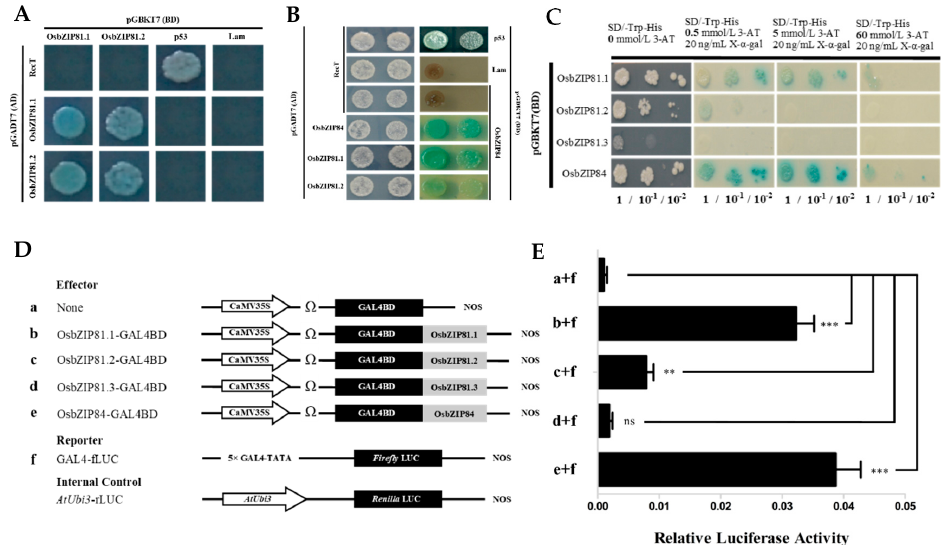
Figure 4. The self-activating activity test of the proteins encoded by OsbZIP81 and OsbZIP84 . ( A ) and ( B ) Yeast two hybrid experiments for dimer detection among OsbZIP81.1, OsbZIP81.2, and OsbZIP84. ( C ) Self-activation activity assay. The concentrations of 3-AT were set as 0, 0.5, 1, 3, 5, 10, 15, 30, 60, and 120 mmol / L, and this figure only shows partial results. ( D ) Schematic of the vectors used in the rice protoplast co-transformation assay. ( E ) Transcription activities of OsbZIP81 and OsbZIP84 . The activity of GAL4-Flirfly luciferase (fLUC) was used as the reporter and that of Renilla luciferase (rLUC) was used as an internal control. The fLUC/rLUC ratio represents the relative activity of the gene. The values in each column are the means of at least three independent replicates and error bars represent the SEM. The asterisks represent a significant difference determined by the Student’s t test, triple asterisks indicate p -value <0.001, the double asterisks indicate p -value <0.01, and ns indicates p -value >0.05.